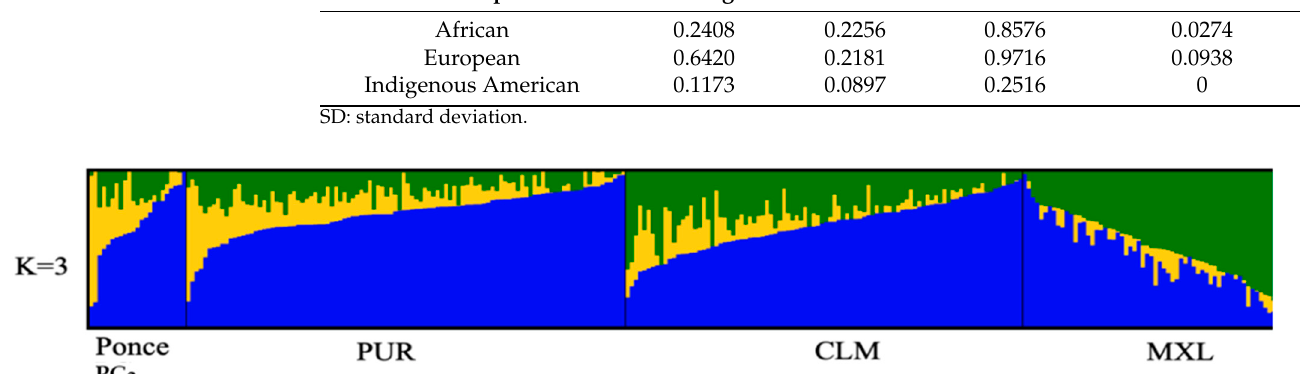
Figure 4. Visualization of the ancestry proportions for each individual in 23 PR H/L men with PCa (Ponce PCa) compared to 1000 Genomes Admixed Americans populations. Assuming three ancestral populations (k = 3), each column represents one individual, and each color corresponds to the contribution of each ancestral population to the genome of a given individual (blue = European, yellow = African, and green = Indigenous American). PUR Puerto Ricans from Puerto Rico, MXL Mexican Ancestry from Los Angeles, CLM Colombians from Medellin, Colombia, and PEL Peruvians from Lima, Peru from the 1,000 Genomes project. Table 3. Ancestry proportions in the study cohort of 23 Puerto Rican men with prostate cancer.